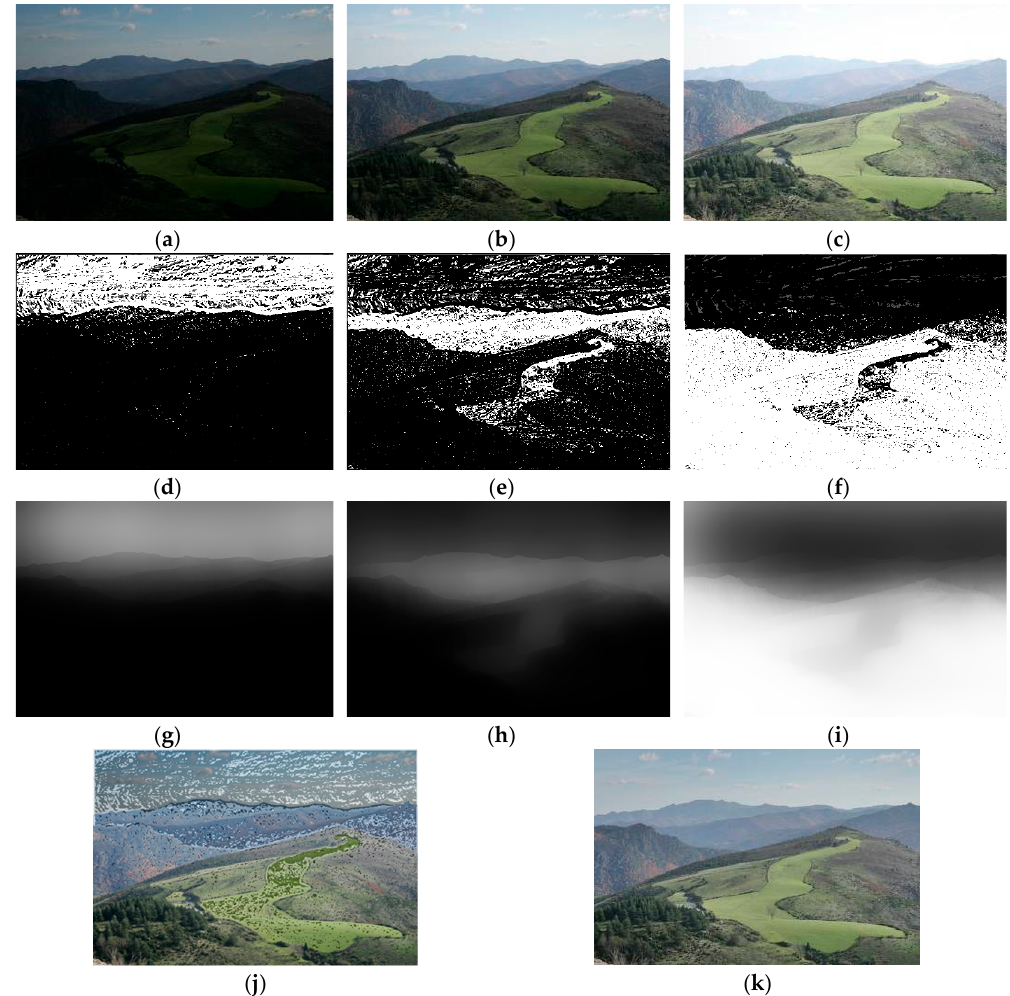
Figure 13. Performance comparison of fusion results between without recursive filter and with recursive filter. ( a – c ) multi-exposure source images; ( d – f ) weight map without recursive filter; ( g – i ) weight map with recursive filter; ( j ) fused image without recursive filter; and ( k ) fused image with recursive filter.